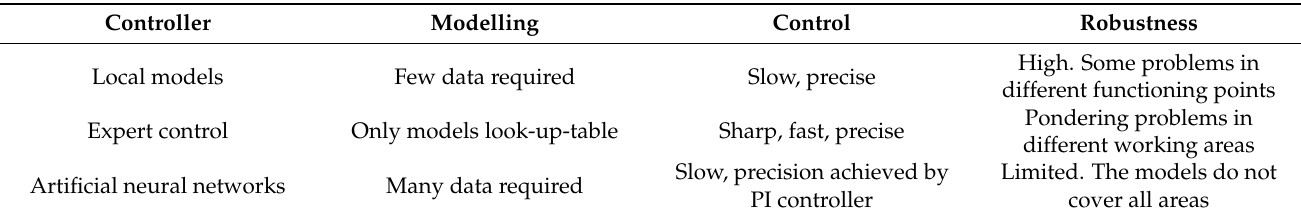
Table 3. Comparison of the control techniques studied.